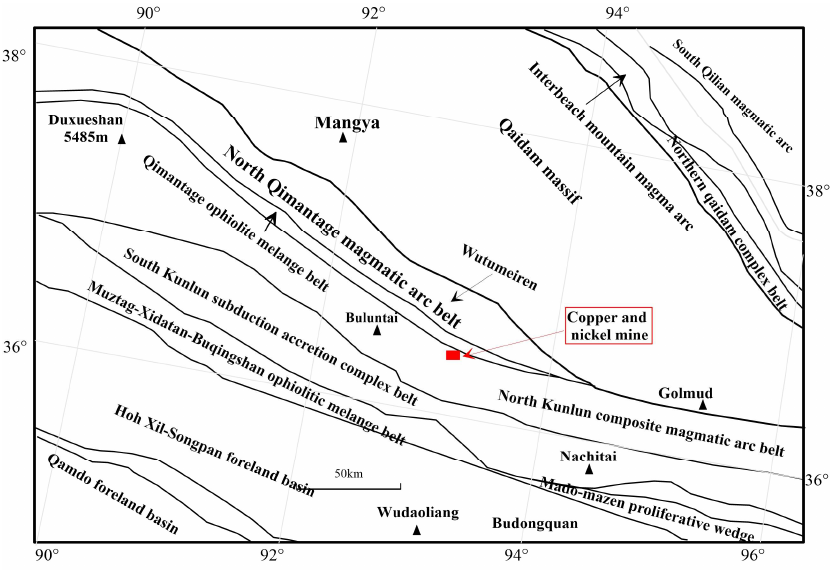
Figure 6. Regional structure map of the Cu-Ni mining study area.